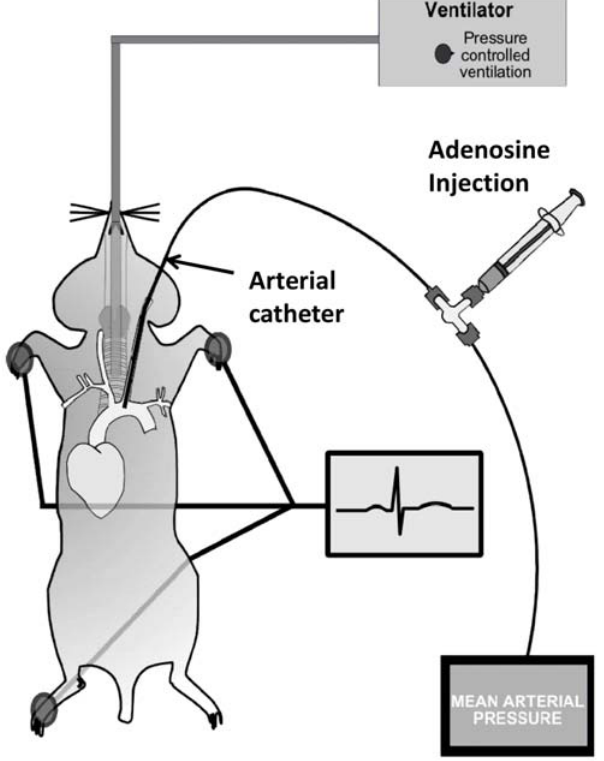
Figure 1. Invasive measurement of hemodynamic parameters in mice. Mice were anesthetized with pentobarbital, mechanical ventilation was instituted and mice were ventilated using pressure- controlled settings (inspiratory pressure of 15 mbar, positive end- exspiratory pressure 5 mbar, 60% inspired oxygen concentration). The common carotid artery was cannulated utilizing a polyethylene tube. The arterial catheter was connected to a pressure transducer which automatically calculated the HR by analyzing the amplitude of the pressure signal. For verification of heart measurements, an electrocar- diogram (ECG) monitor was connected throughout the experiment. Values were recorded to computer hard drive for further analysis.